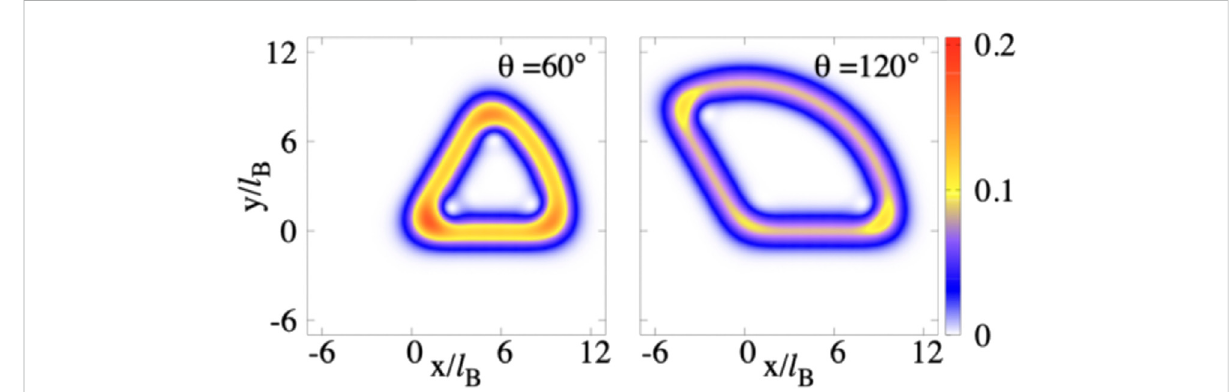
FIGURE 4 Single particle density for the state which has eigenvalue with the smallest | λ − 1 (cid:1)(cid:1)(cid:1)(cid:1) √ physical edge R (cid:2) 342